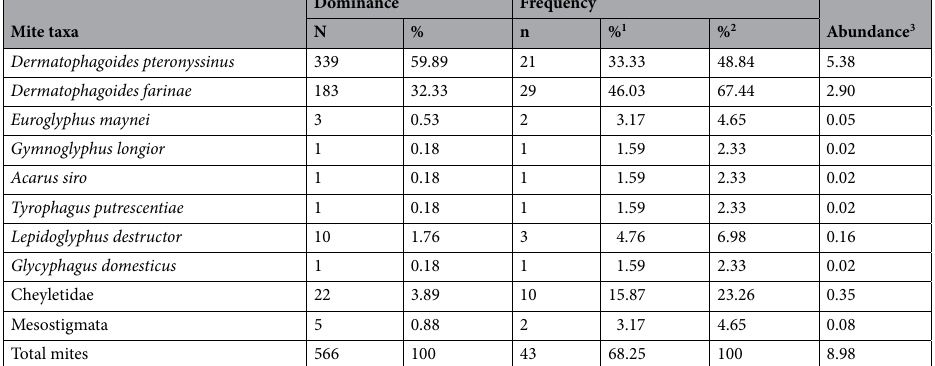
Combinations of mite taxa Number of samples positive [Proportion] 1 Samples containing only pyroglyphid mites 28 [0.44] DP 7 [0.11] DF 18 [0.29] Samples with pyroglyphid and non-pyroglyphid mites 15 [0.24]